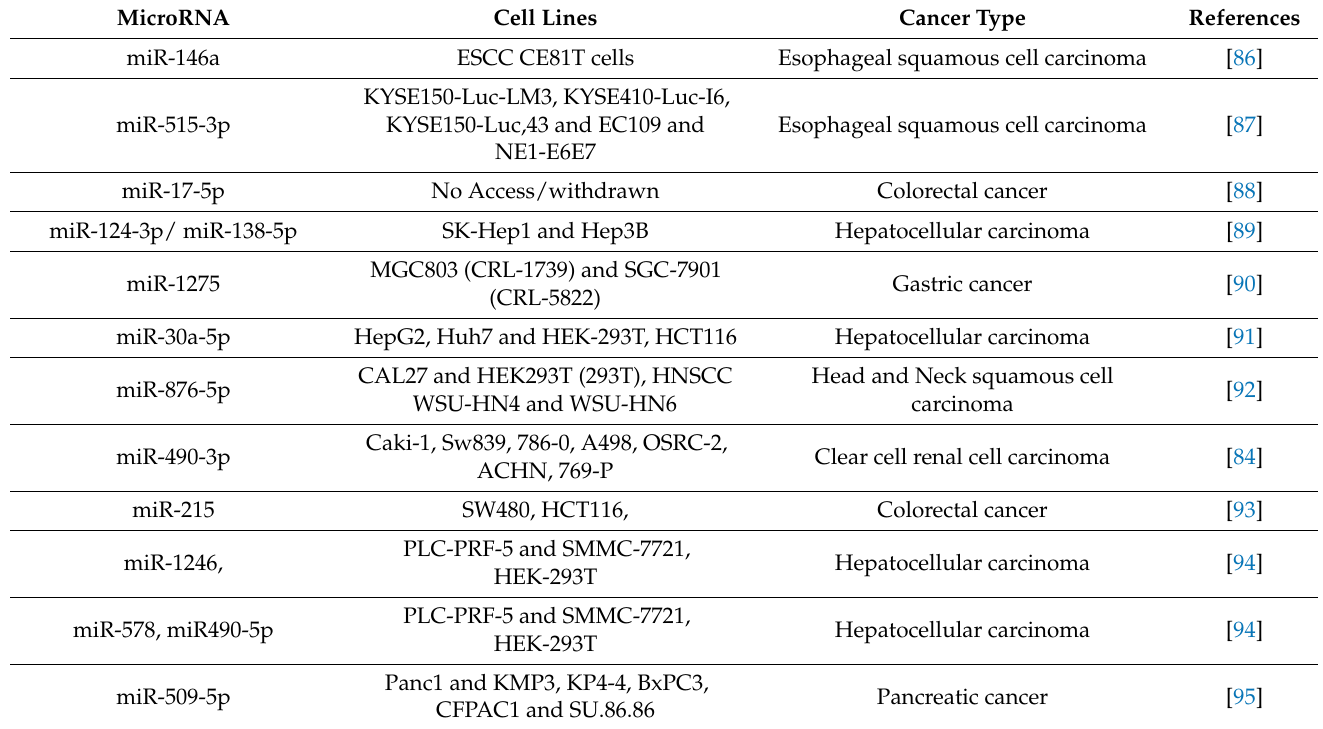
Table 1. List of microRNAs and non-coding RNAs which are shown to downregulate vimentin by degrading its mRNA in different human cancer cell